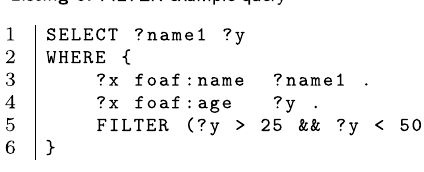
Table 14 Operation order for each query plan of C2 (300M) Plan Separate into 2 subgroups and combine all later Operation